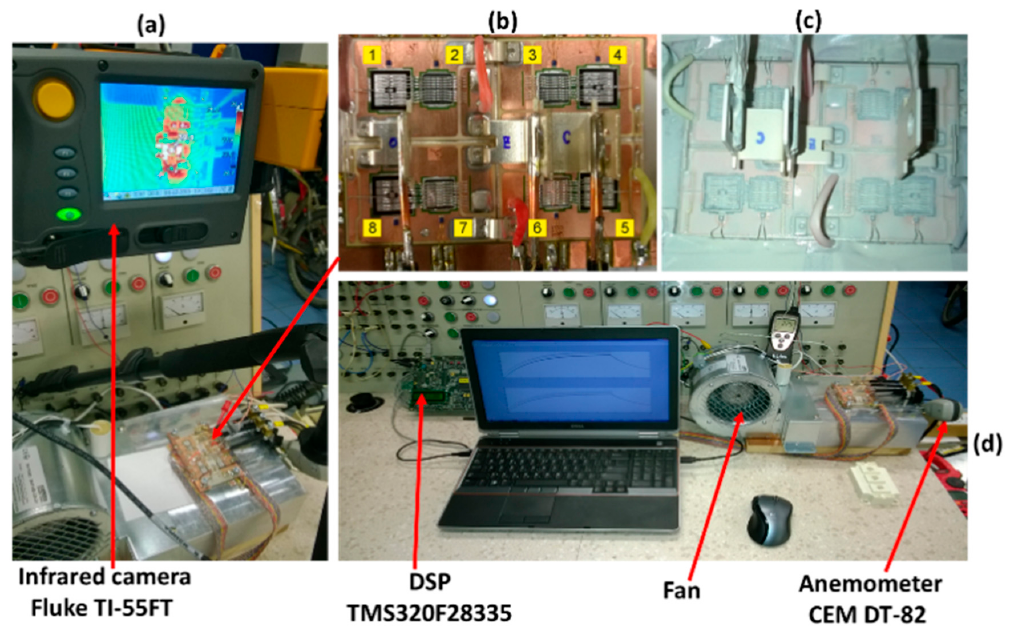
Figure 1. Direct temperature measurement test bench. ( a ) infrared camera; ( b ) Eight temperature sensors; ( c ) open IGBT module; ( d ) cooling fan.